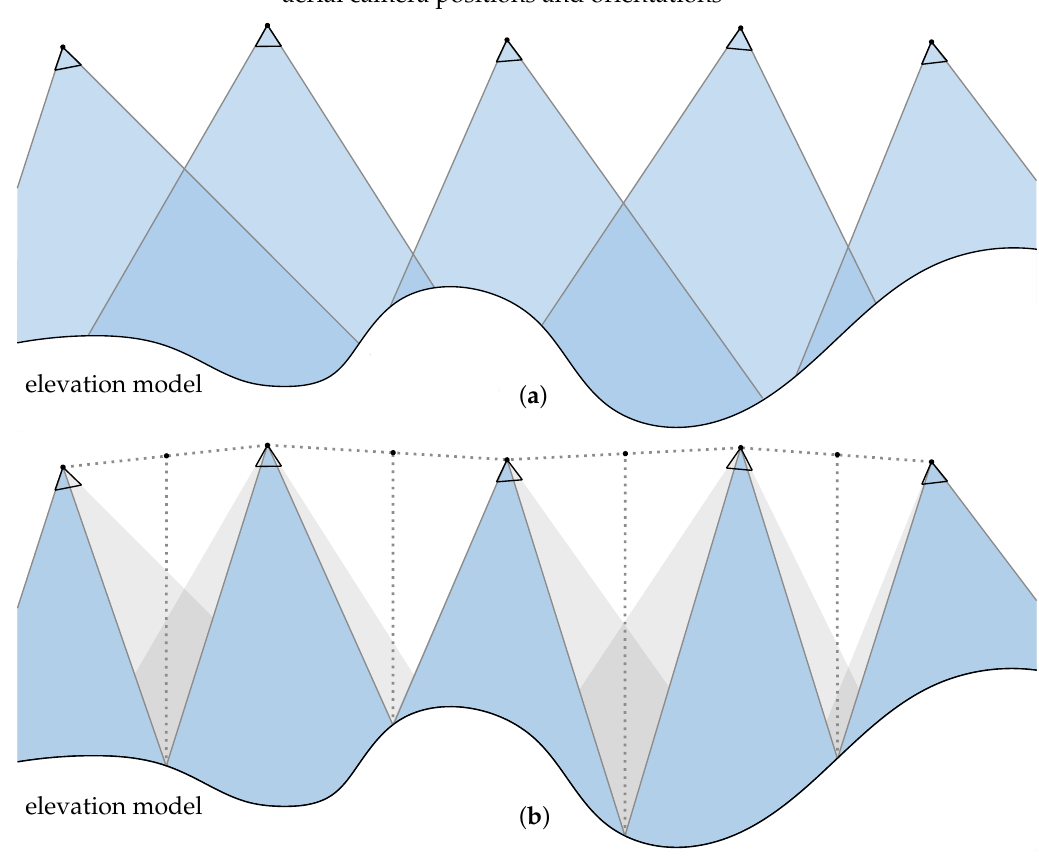
Figure 3. Aerial imaging of a non-planar terrain and view cone overlap visualization (profile view): ( a ) full frame coverage and view cone overlap; and ( b ) minimized view cone overlap of clipped aerial images by application of TAC